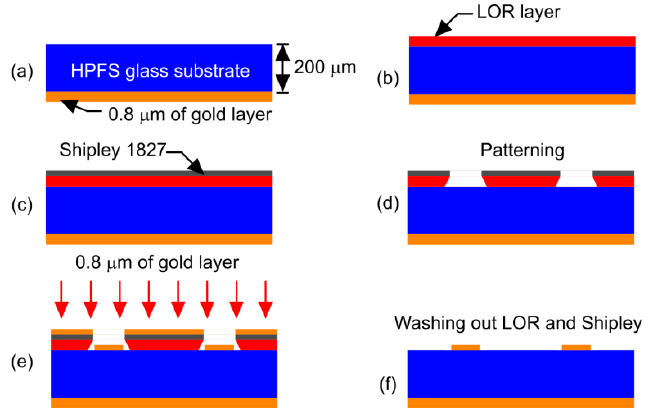
Figure 24. A tentative fabrication method to fabricate the designed Butler matrices. ( a ) Deposition of titanium layer and gold layer on the backside of the RCA cleaned HPFS glass substrate layer. ( b ) Deposition of LOR layer on the top layer of HPFS glass substrate. ( c ) Deposition of photoresist layer over the LOR layer. ( d ) Patterning of LOR and photoresist layers. ( e ) Deposition of gold layer by e-beam evaporation method. ( f ) Removal the LOR and photoresist layers to get the final Butler matrix circuit patterned with gold layer.